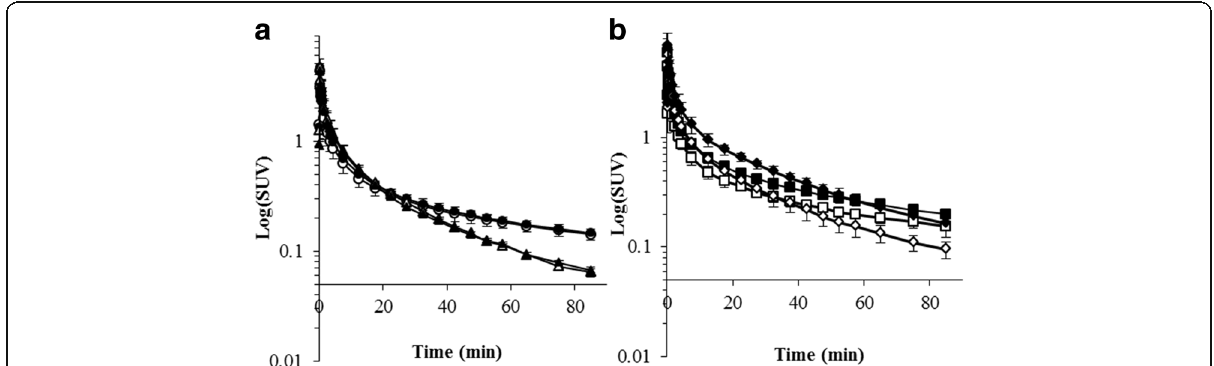
Fig. 4 Left ventricle time activity curves after 18 F-FPP-RGD 2 injection in mice fed a control ( a ) or methionine choline-deficient, L -amino acid-defined, high-fat diet (CDAHFD) ( b ) ( n =5 per group). Sixty micrograms of c(RGDfK) was co-injected with 18 F-FPP-RGD 2 into each group for the blockade study ( n =3 per group). white circle, control 3 weeks; black circle, CDAHFD 3 weeks; white triangle, control 3 weeks +cRGDfK; black triangle, CDAHFD 3 weeks+cRGDfK; white square, control 8 weeks; black square, CDAHFD 8 weeks; white diamond, control 8 weeks +cRGDfK; and black diamond, CDAHFD 8